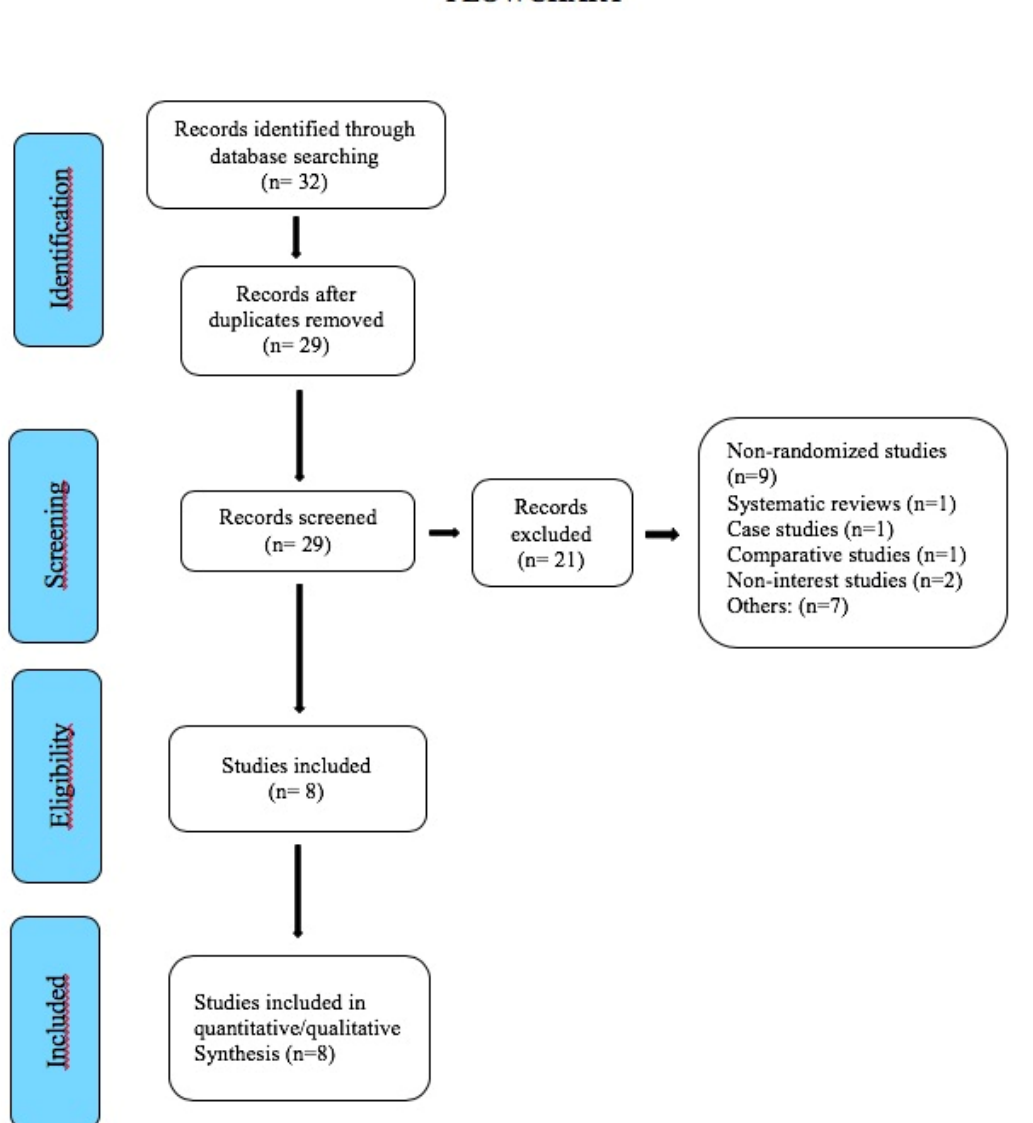
Figure 1. Flowchart of the study selection process. PRISMA (Preferred Reporting Items for Systematic Review and Meta-Analyses) [16].